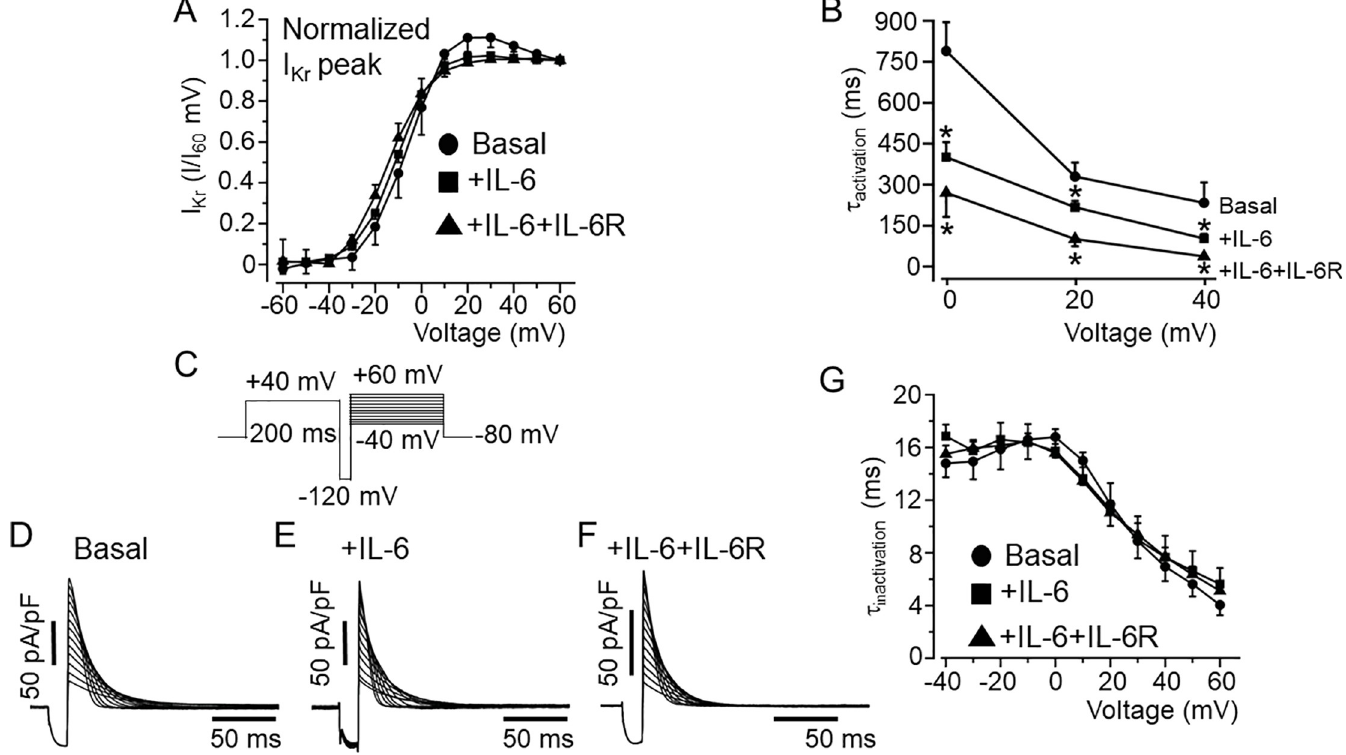
Fig 2. Effects of IL-6 on I activation and inactivation kinetics in HEK-hERG cells. A , Plots of I Kr +IL-6R. Compared to control I Kr currents (circle, n = 21), the normalized tail currents show that I Kr activates at more negative potentials in the presence IL-6 (square, n = 18) and IL-6+IL-6R (triangle, n = 9). B , Plots of activation time course ( τ activation ) and voltage relationship for basal I (square, n = 18) or IL-6+IL-6R (triangle, n = 9). The time course of inactivation ( τ inactivation ) was examined using the protocol shown in C . D , representative I Kr current traces recorded under basal conditions, and in the presence of IL-6 ( E ) or IL-6+IL-6R ( F ). G , graph of the voltage-dependence of the τ inactivation during basal I n = 8), +IL-6 (square, n = 7), +IL-6+IL-6R (triangle, n = 5) conditions.